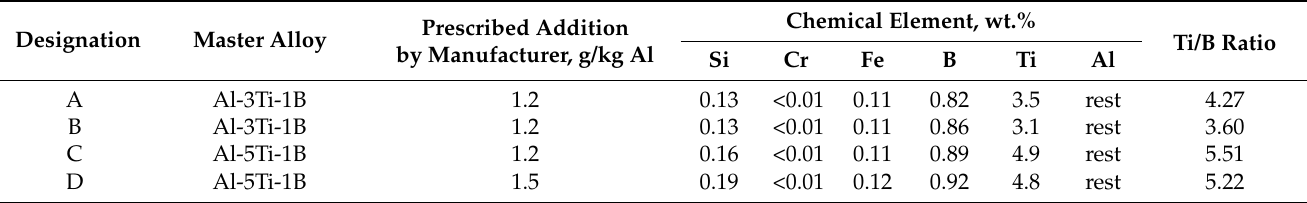
Table 1. Chemical composition and designations of investigated grain